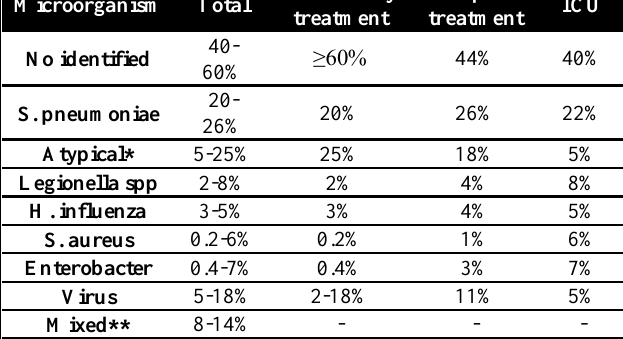
Table 1: Etiology of community acquired pneumoniae. ICU: Intensive care unit. *Considering M. pneumoniae (the most frequent), C. pneumoniae, C. psittaci and C. burnetii. ** Most common associations: S. pneumoniae plus C. pneumoniae or